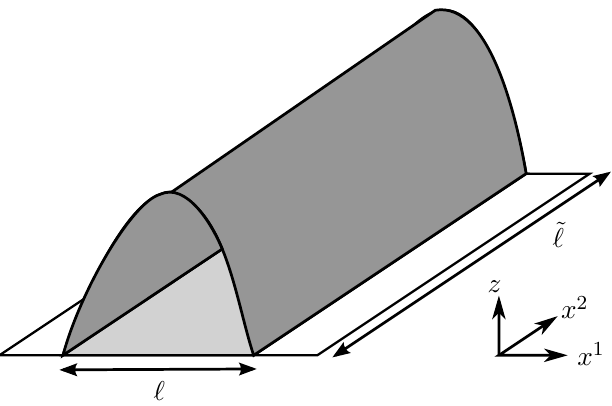
Figure 5. Holographic calculation of the Wilson